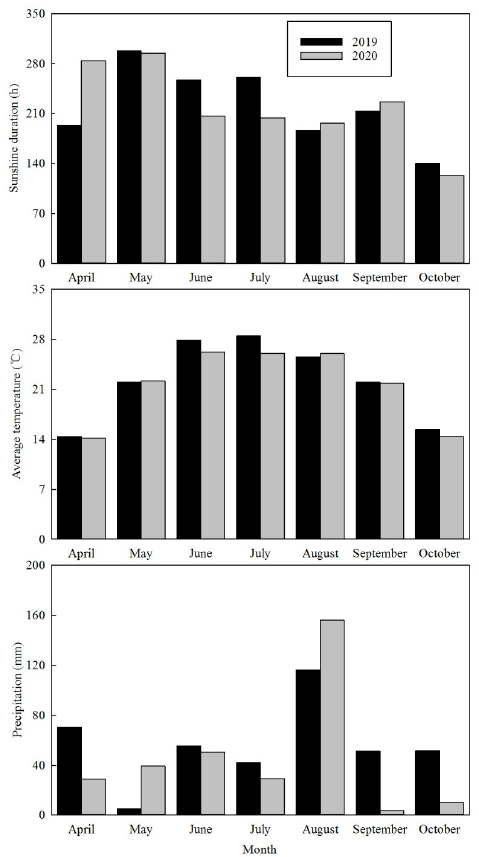
Figure 1. Monthly meteorological data during the 2019–2020 cotton-growing periods at the test station in Anyang. The meteorological data were obtained from an automatic weather station located ~4 km from the test station.